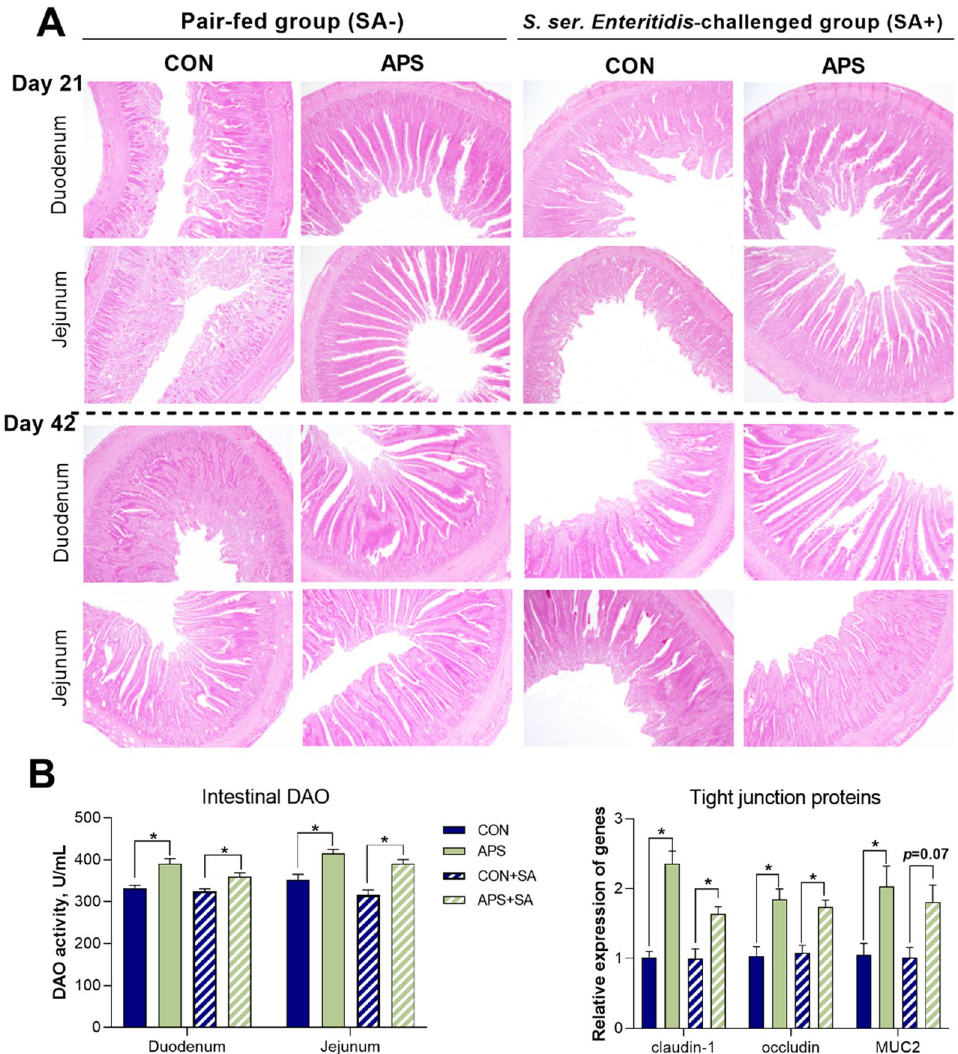
Figure 2. Effect of APS supplementation on gut development, intestinal mucosa enzyme activity and tight junction-related protein mRNA expression in pair-fed vs. S. ser. Enteritidis -challenged groups. ( A ) Hematoxylin and eosin (HE) staining of the duodenum and jejunum on days 21 and 42 in the four experimental groups (n = 6). The villus and crypts from each segment were measured with a light microscope equipped with Image-Pro Plus software (version 6.0, Motic Images software, Motic China Group Co., Ltd., Xiamen, China, https:// www. semi. org/ en/ resou rces/ member- direc tory/ motic- china- group- co- ltd) and stained with HE, × 100 magnification, ( B ) The diamine oxidase (DAO) activity in the duodenal and jejunal mucosa and mRNA expression of tight junction-related proteins in the jejunum, including claudin-1, occludin, and MUC-2 (n =